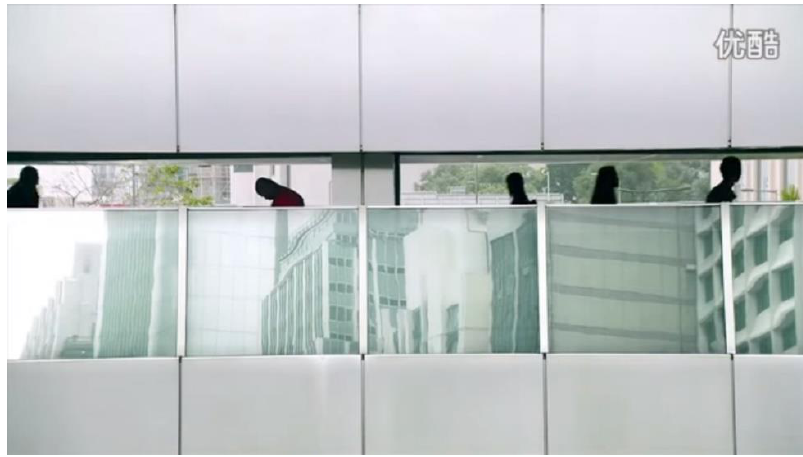
Figure 8. The walker amidst the flow of human traffic in Hong Kong’s Central Business District.